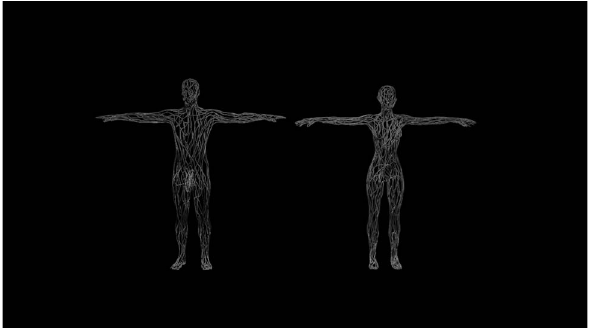
Figure 8: Screenshot of orgy VMSE taken from Oculus Quest. The 3D CG models engaging in various sexual